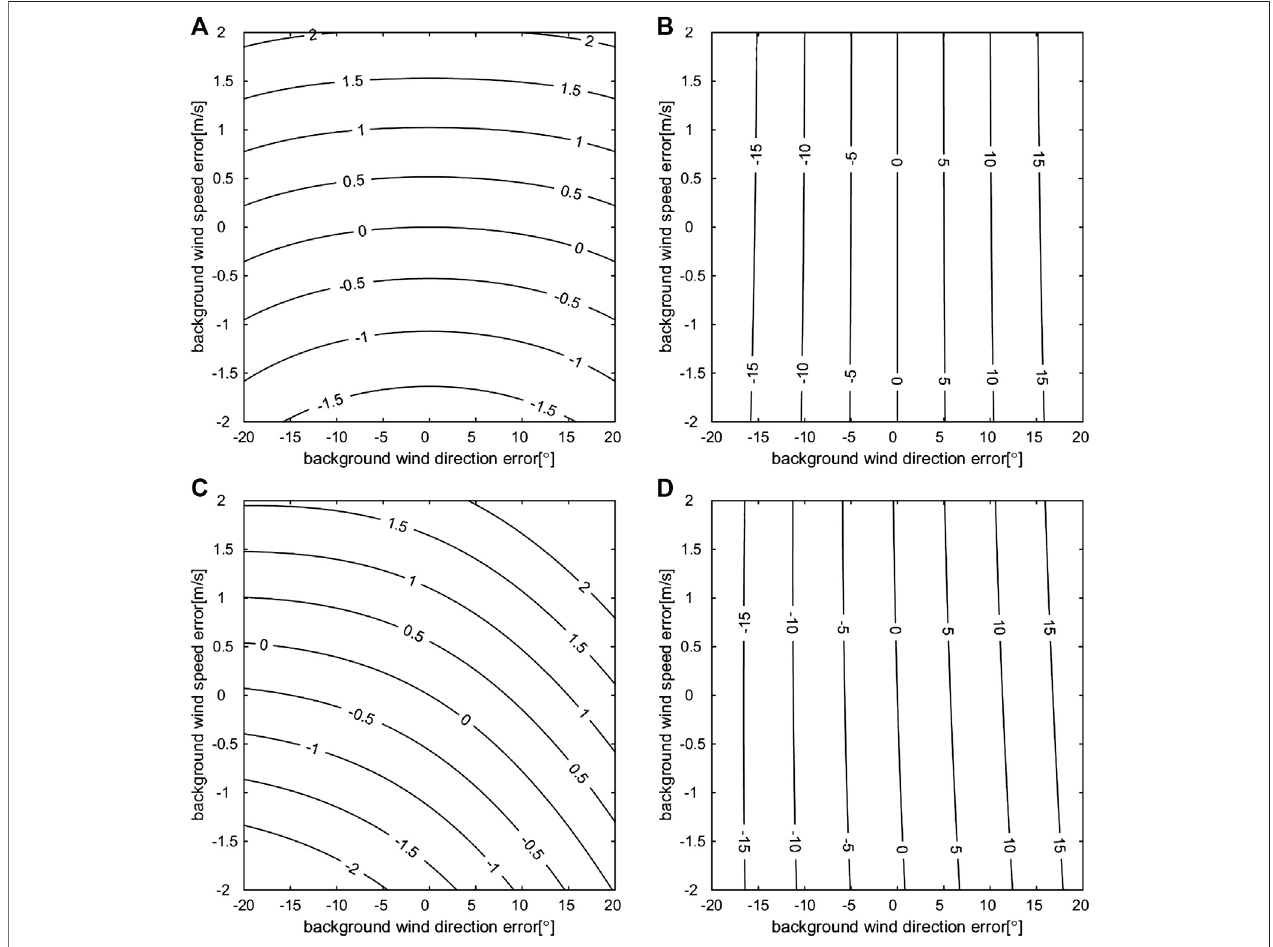
FIGURE4| OI-retrievedwindspeederrors (A , C) andwinddirectionerrors (B , D) (theisolines)whenthetruespeedis25 m/s,andthetruewinddirectioniseither0 ° (A , B) or 45 ° (C , D) ; the background wind speed errors (Y axis) and the background wind direction errors (X axis) are given.